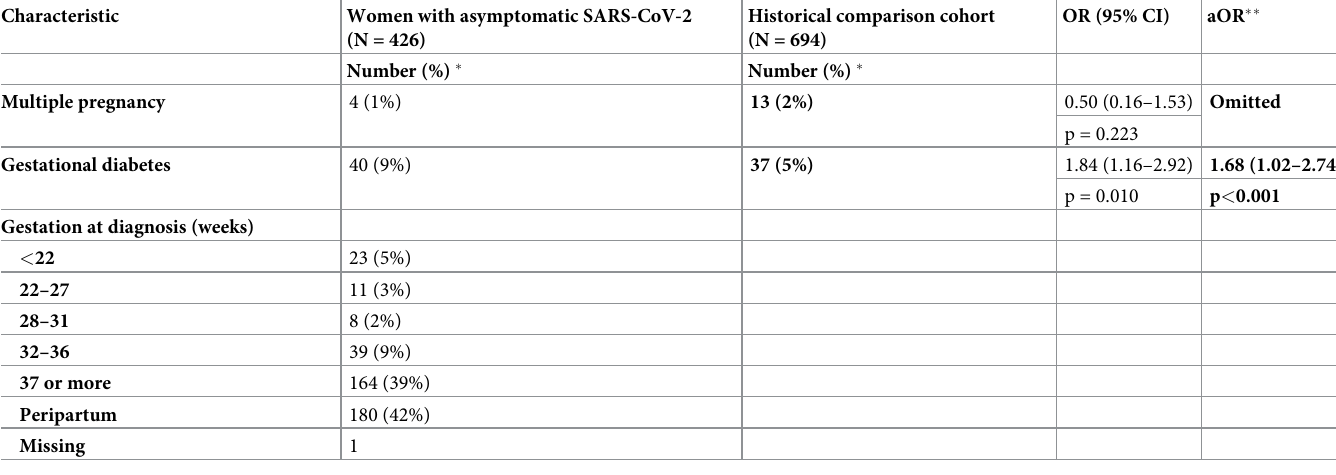
Of the 722 women admitted to hospital with symptomatic SARS-CoV-2, 89% (n = 640) had completed their pregnancy at the time of analysis (Table 3, two were missing further details and infant outcomes so were excluded from the denominator). In total, 2% (n = 16) of women with symptomatic SARS-CoV-2 had a pregnancy loss prior to 24 weeks’. Early pregnancy out- comes were not compared with the historical comparison group due to the risk of measure- ment bias resulting from screening for SARS-CoV-2 on admission to hospital with symptoms of pregnancy loss. Nearly half of women gave birth by cesarean section (n = 314, 49%), with 64 (6%) being for maternal compromise secondary to SARS-CoV-2 (S7 Table). This represents approximately double the risk of cesarean section for women with symptomatic SARS-CoV-2 compared to the historical comparison cohort without SARS-CoV-2 (pre-labor cesarean aOR 2.58, 95% CI 1.88–3.55 and cesarean after labor onset aOR 2.72, 95% CI 1.79–3.86). Operative vaginal births were also increased (aOR 2.14, 95% CI 1.42–3.24). Only 18 women received antiviral agents, two of whom were recruited to the RECOVERY Trial [16]. The most com- monly used antiviral agent was oseltamivir (n = 11, 1%). Approximately 1 in 8 symptomatic women received steroids to enhance fetal lung maturation (17%, n = 120) and 1 in 5 symptom- atic women had a preterm birth. The majority of preterm births were iatrogenic and the risk of a woman with symptomatic SARS-CoV-2 having an iatrogenic preterm birth was more than 10-fold higher compared to pregnant women without SARS-CoV-2 (14% vs. 1% aOR 11.43, 95% CI 5.07–25.75). Whilst there was an apparently lower proportion of spontaneous preterm births amongst women admitted with symptomatic SARS-CoV-2, this was partly explained by confounding (4% vs. 7%, aOR 0.57, 95% CI 0.32–1.01, Table 3). In comparison with women found to have asymptomatic SARS-CoV-2 on hospital admis- sion, women with symptomatic SARS-CoV-2 were more likely to have a cesarean birth (prela- bor cesarean: 32% vs. 26%, OR 1.51, 95% CI 1.11–2.06 and cesarean after labor onset: 18% vs. 14%, OR 1.58, 95% CI 1.08–2.31) (Table 4). Although the risk in the asymptomatic SARS-- CoV-2 group was also increased compared to the historical comparison cohort without SARS-CoV-2 (Table 5) (pre-labor cesarean 26% vs. 18%, aOR 2.26, 95% CI 1.62–3.17; cesarean after labor onset 14% vs 11%, aOR 1.67, 95% CI